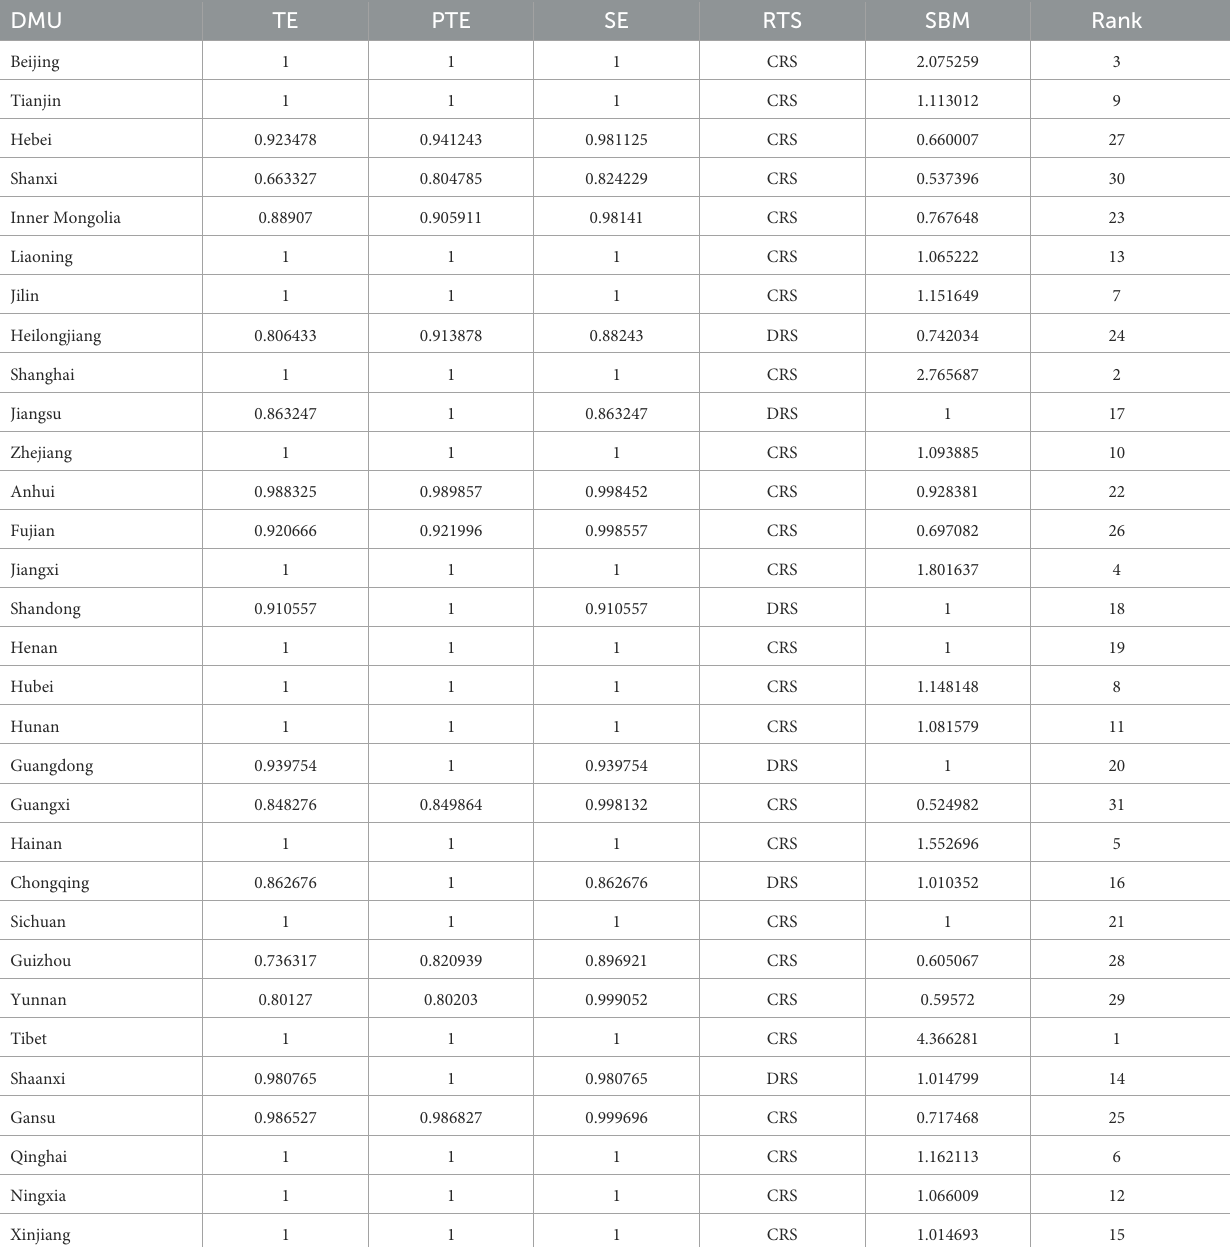
TABLE 1 The overall efficiency evaluation of LTCFs in China in